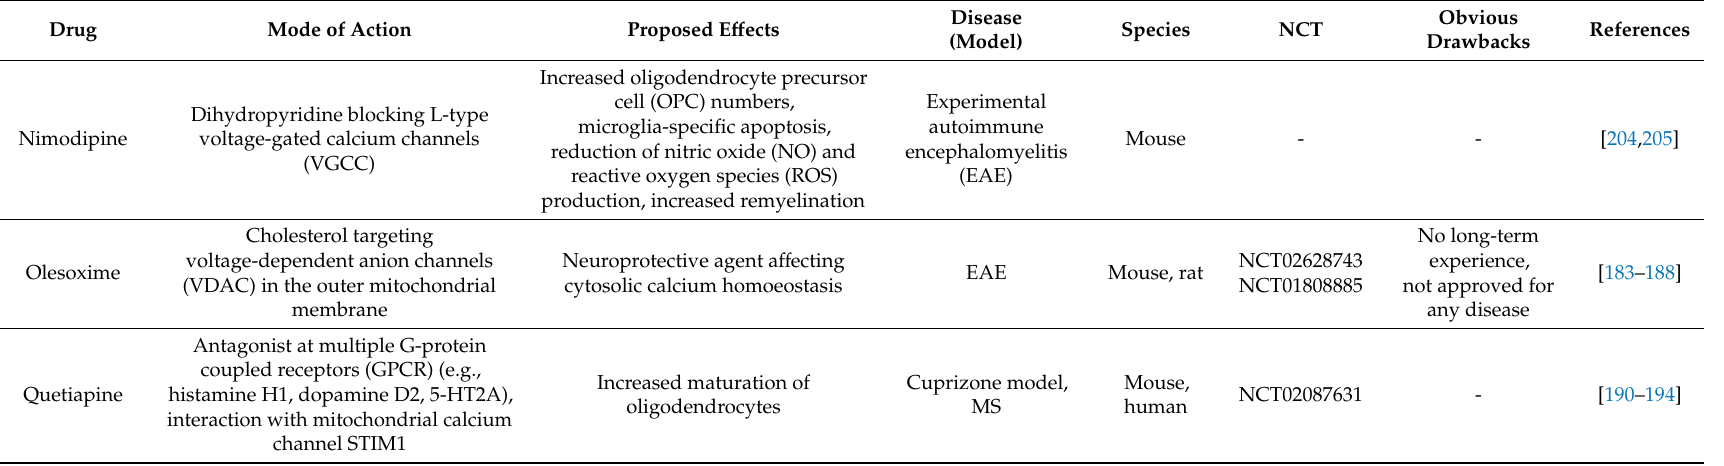
Table 1. Drugs which directly interfere with calcium signaling and may potentially be neuroprotective in multiple sclerosis